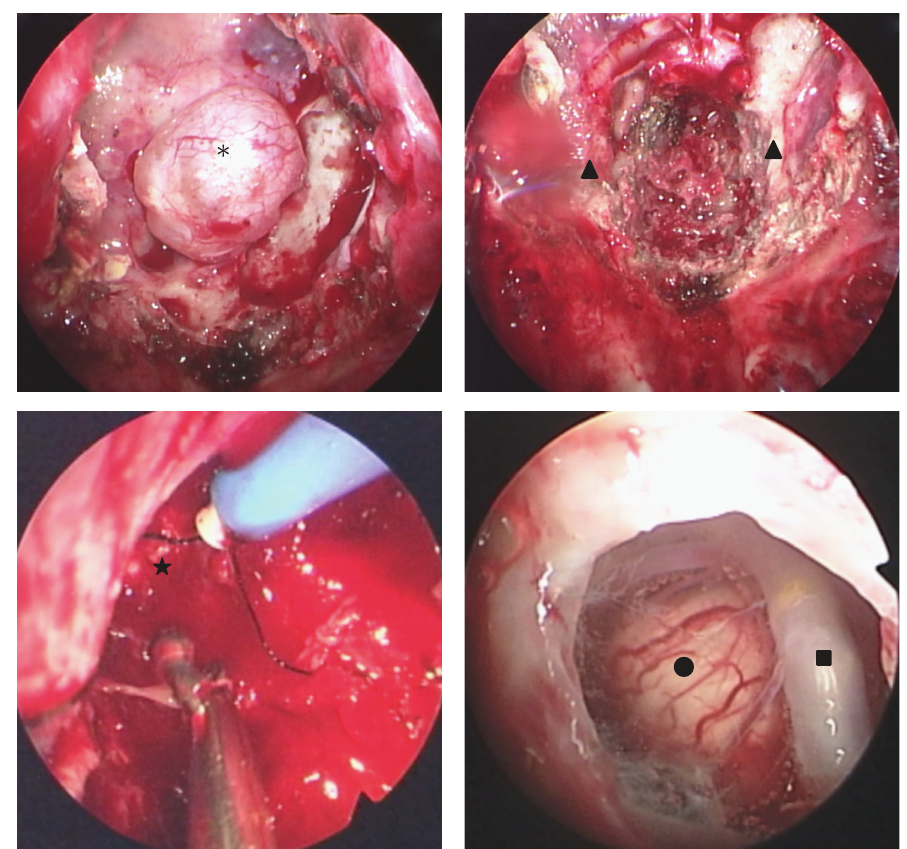
Figure 4: Case 2. Intraoperative endoscopic view. Upper left: tumor capsule extending sphenoid sinus (asterisk), right: bilateral carotid prominence and expose carotid artery (triangle), lower left: lateral part of the lesion (star). Endoscope with long axis gave us clear operative view but di ffi cult to reach surgical instruments and intratumoral manipulation. Lower right: We could observe the surface of brainstem and basilar artery through dural defect. basilar artery (square), brainstem